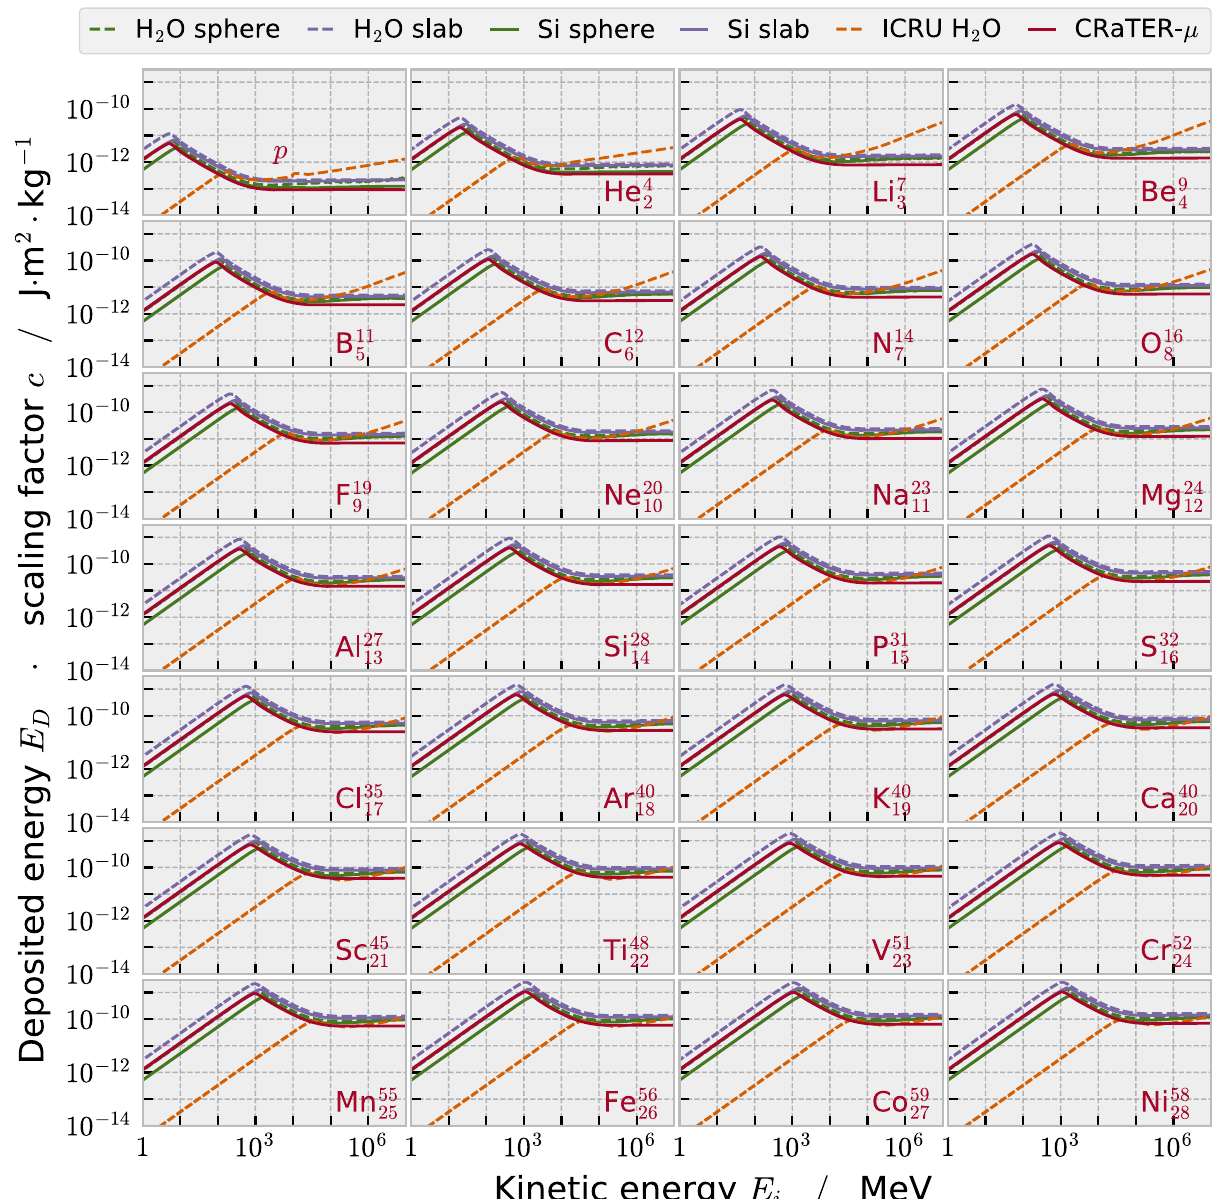
Fig. A1. Absorbed dose due to heavy particles multiplied by factor C (Eq. (2)) takes in to account the fact that the phantoms have different masses and sizes. After doing so, we can compare the relative differences in absorbed dose rate that different phantoms would suffer if they were placed in to the same radiation fi eld. Full lines correspond to silicon phantoms, while dashed lines are used for H 2 O phantoms. The different shapes and sizes are indicated with colors. We see that the the relation between phantom size and measured dose has a non trivial dependence on particle type and energy. The calculated data indicates that the silicon phantom suffers a higher absorbed dose than the ICRU phantom for most particle types and